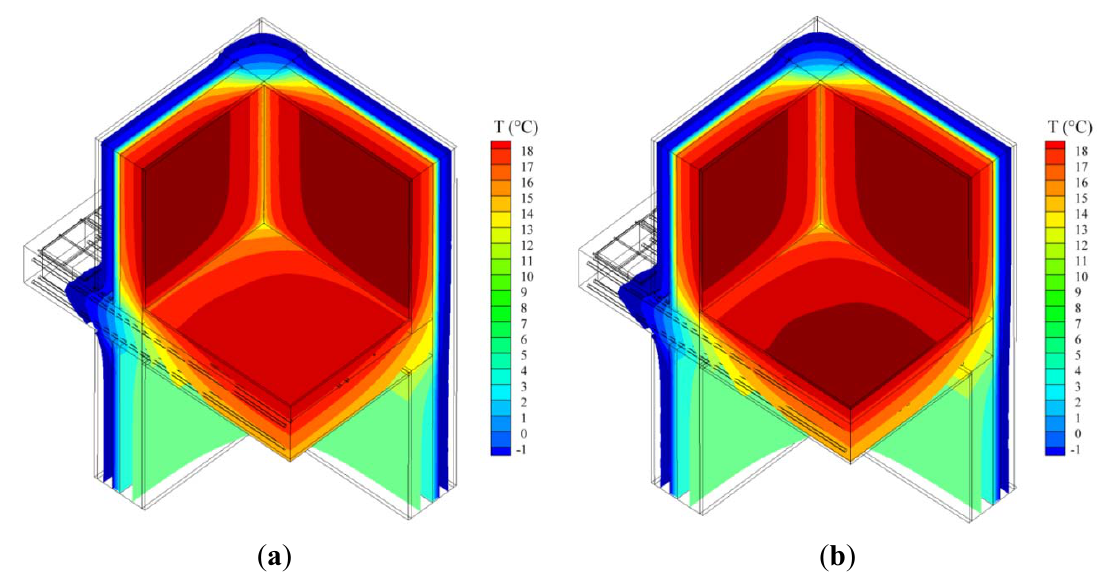
Figure 9. Temperature contours obtained after seven days (168 h) employing two different ( a ) and C ( b ). concrete mixtures: C 0 30